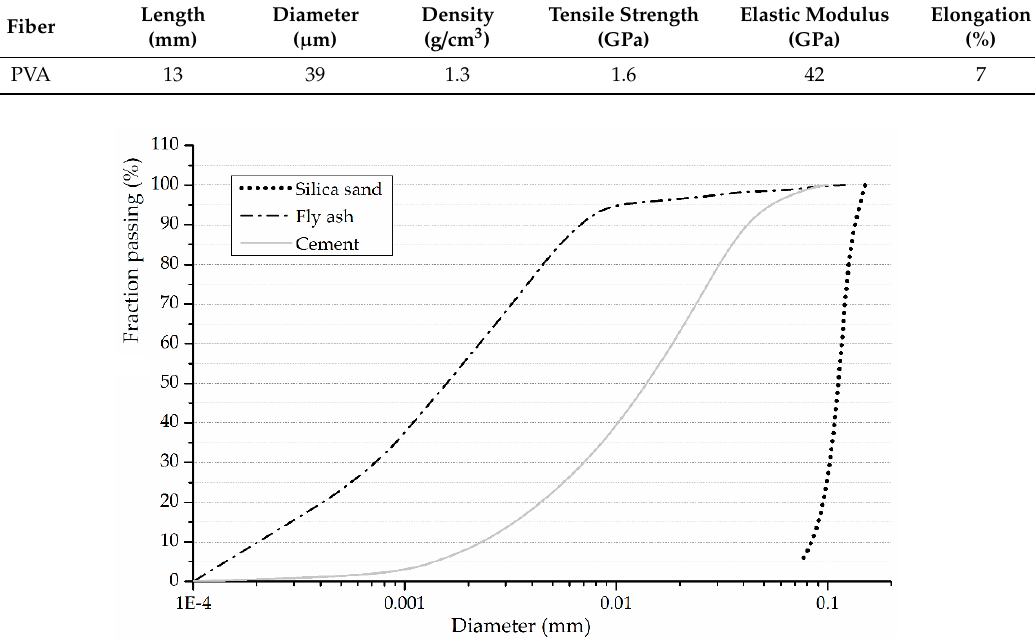
Figure 1. The particle size distributions of P.O. 42.5 type cement, ground fly ash and silica sand.